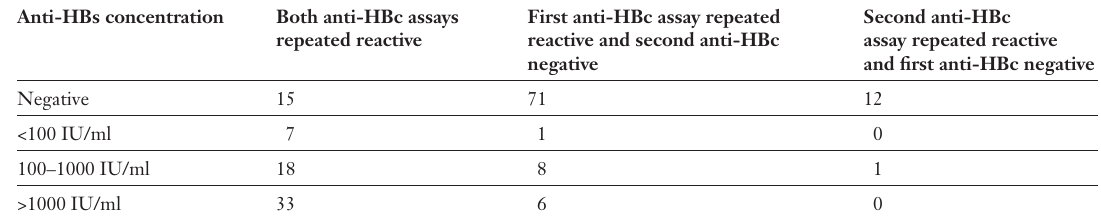
Table 4 Concentrations of anti-HBs compared to the results of anti- HBc assays for dona- tions from BTS